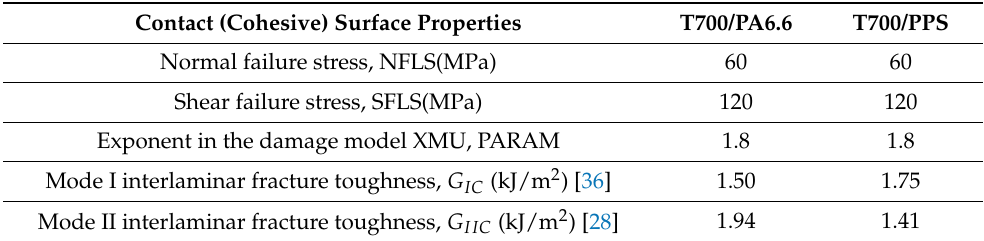
Table 7. Properties of the contact